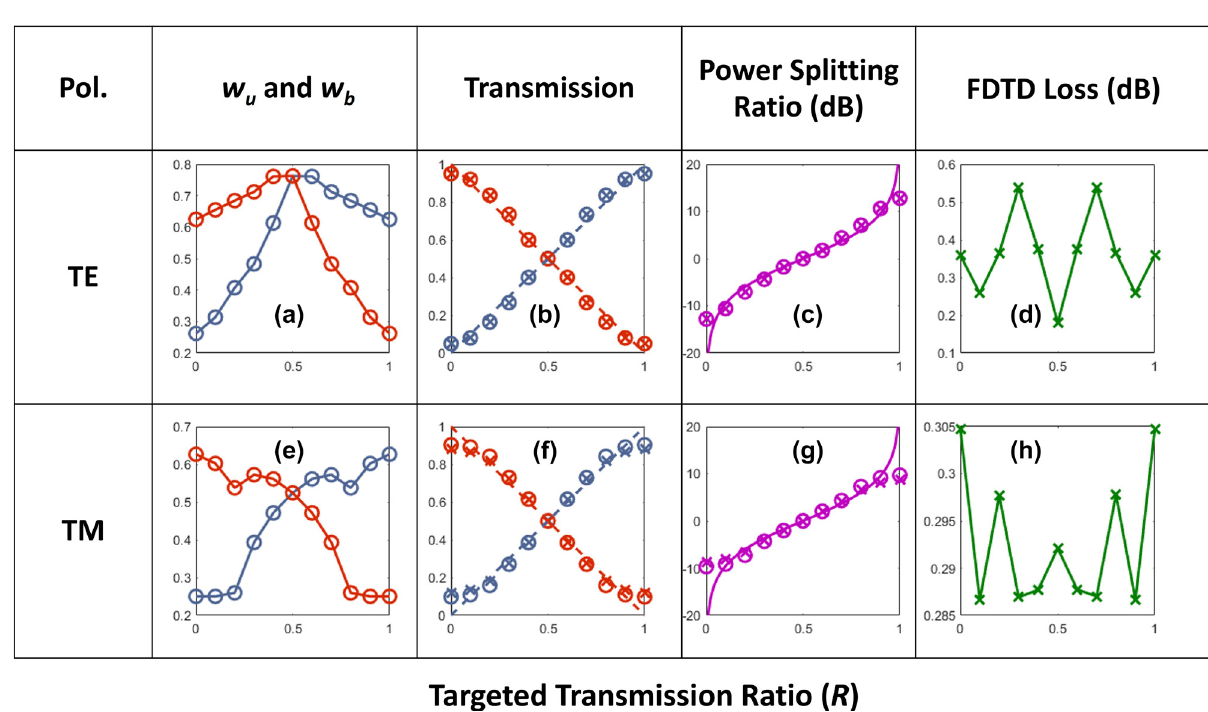
Figure 5: Graphical illustration of the inverse design results for L = 2 μ m as a function of targeted transmission ratio ( R ). (a)–(d) TE-polarization. (a) Inverse-designed geometrical parameters. (b) The transmission for the devices with w and w as in (a). (d) The FDTD losses for the devices with w with w u b and crosses: 3D FDTD simulations. (e)–(h) Similar results as in (a)–(d) but for TM-polarization.